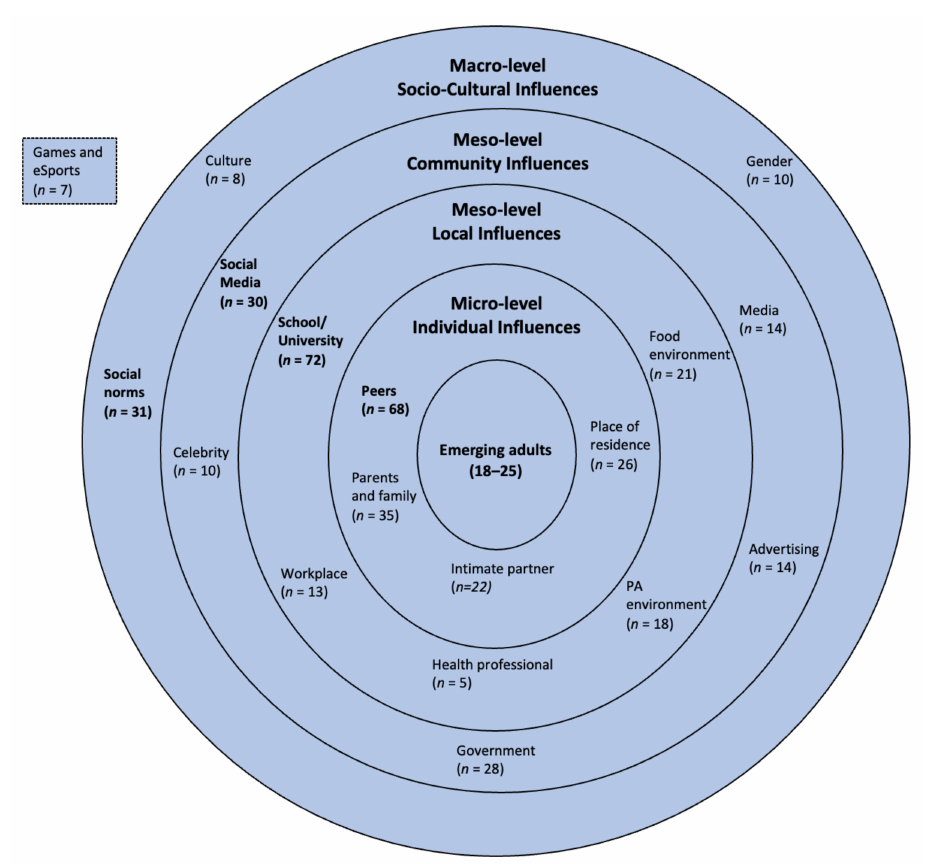
Figure 3. Influences of physical activity and diet behaviour of emerging adults ( n = number of identified studies). Items in bold indicate the highest influence at each